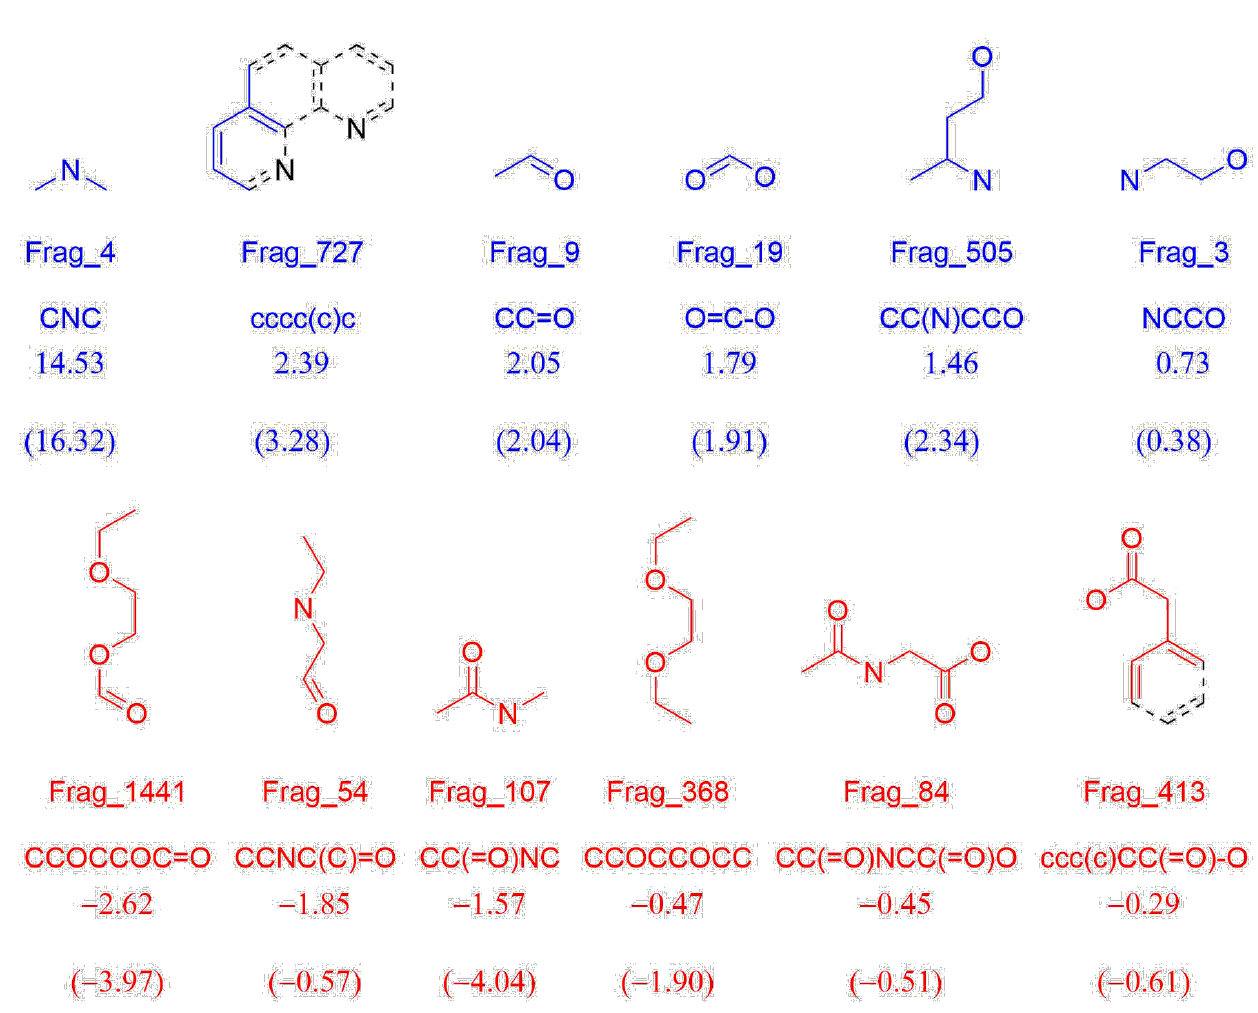
Figure 10. Main molecular fragments (MFs) retrieved by the LASSO model for Eu 3+ complexation. The red-colored fragments have negative values and reduce the logK value. The blue MFs have positive values and improve the complexation ability. Below each MF, there is its name, SMILES notation, LASSO coefficient, and the multilinear coefficient, in